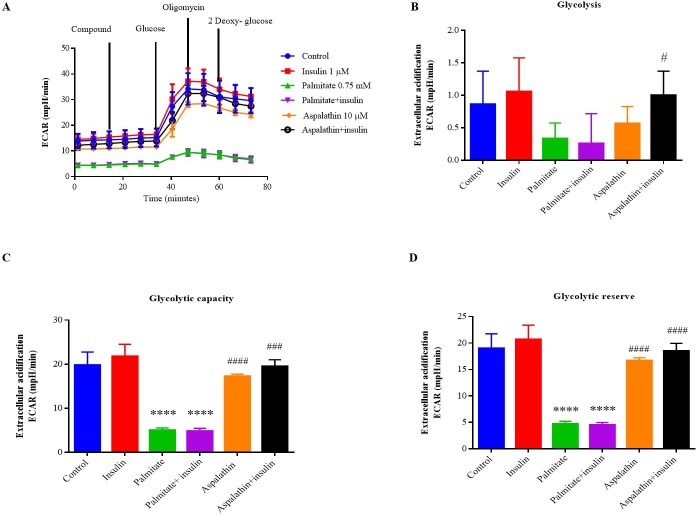
Extracellular acidification rates (ECAR) response of C3A liver cells to aspalathin (10 μM), glucose (10 mM), oligomycin (1 μM) and 2-deoxyglucose (2-DG) (100 mM), respectively (A). Individual parameters for glycolysis, glycolytic capacity, glycolytic reserve of C3A liver cells after aspalathin treatment (B and C), and the effect of palmitate and aspalathin on OCAR/ECAR (D). ECAR was measured under basal conditions followed by the sequential addition of aspalathin (10 μM), glucose (10 mM), oligomycin (1 μM), and 2-deoxyglucose (2-DG) (100 mM) the order was as follows (aspalathin>Glu > Oli > 2-DG). Data are expressed as means ± SEM, n = 3 independent experiments. **** p < 0.0001 versus normal (no insulin) control, #### p < 0.0001 versus palmitate control.